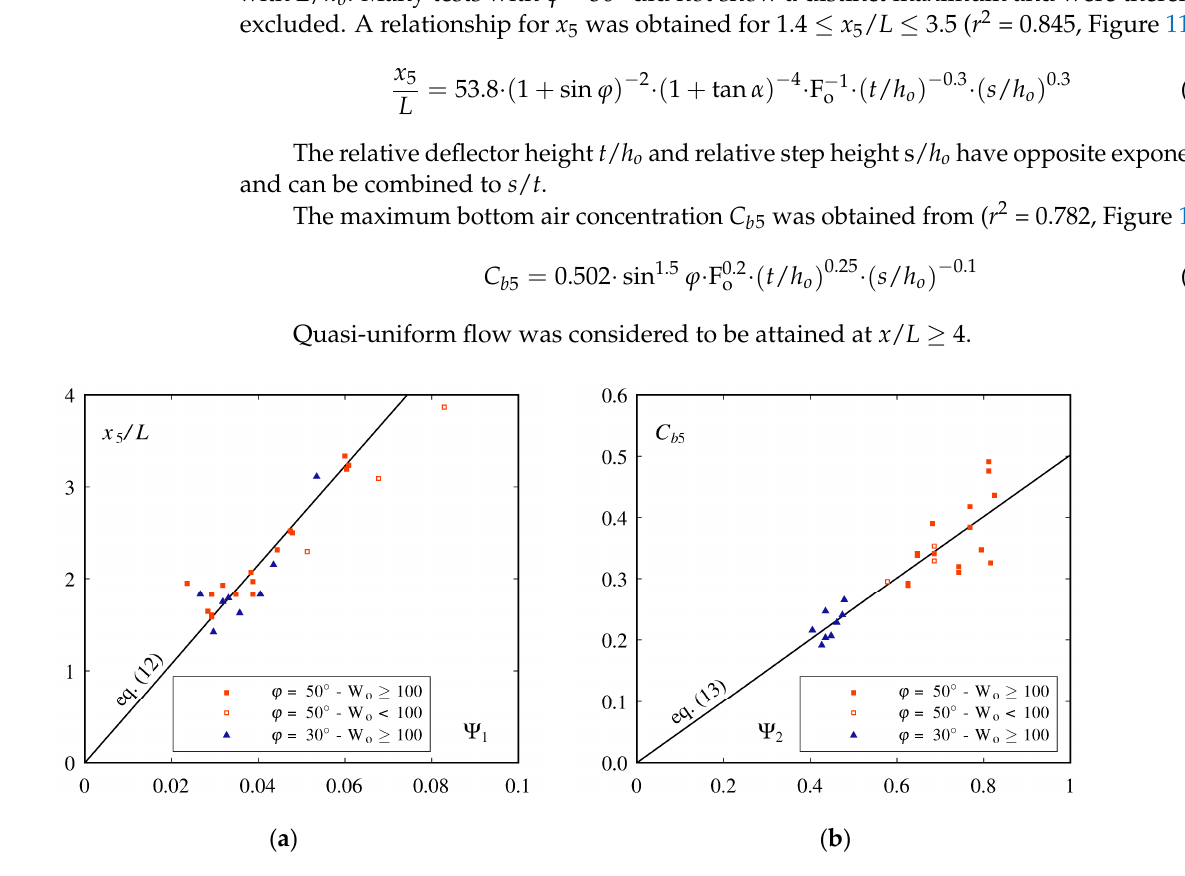
Figure 10. Bottom minimum characteristics: ( a ) relative streamwise position x 4 / L as a function of Ψ 1 = (1 + sin φ ) − 1 ·(1 + tan α ) − 1.75 ·F o − 0.17 ·( t / h o ) − 0.23 , and ( b ) bottom air concentration C b 4 as a function of Ψ 2 = sin 1.4 φ ·(1 + tan α )·F o0.3 ·( t / h o ) 0.15 ·(s/ h o ) − 0.3 .